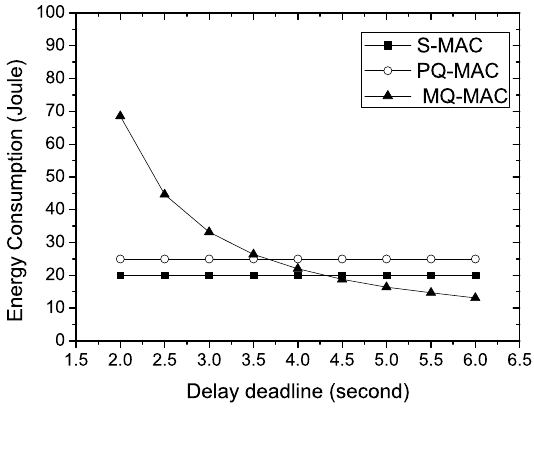
Figure 15. Energy consumption varying delay